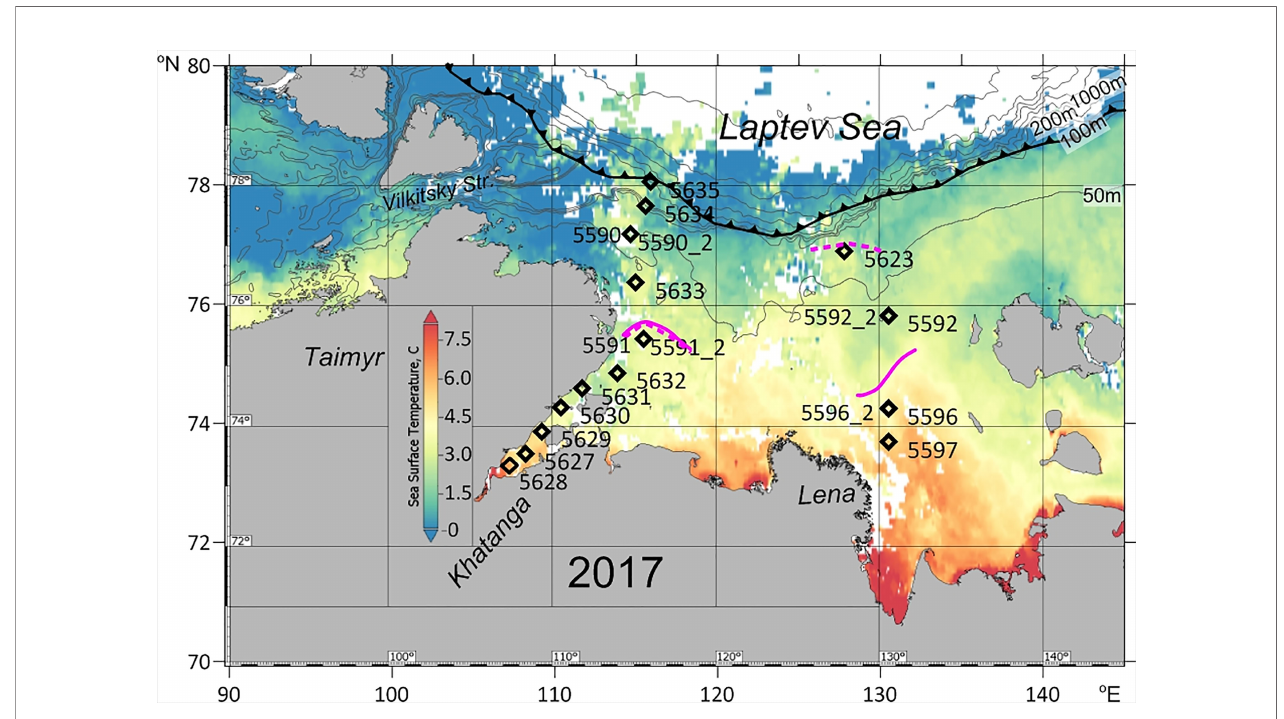
FIGURE 1 | Map of the study area with location of the stations. Sea surface temperature (° C) distribution: average for 29 August – 6 September 2017 (at 11 microns, MODIS-Aqua_L3_SST_8d_4km vR2019.0) (Berrick et al., 2009). Bold lines show the position of the ice boundary (http://www.aari.ru). Magenta lines indicate river plume extension (isohaline of 25): solid line - at the time of fi rst sampling (31.08-3.09. 2017), dashed line - at the time of the repeated sampling (14.09- 20.09.2017). Contour depths in meters. When sampling was repeated, the Lena plume considerably extended to the north, while Khatanga plume remained at the same